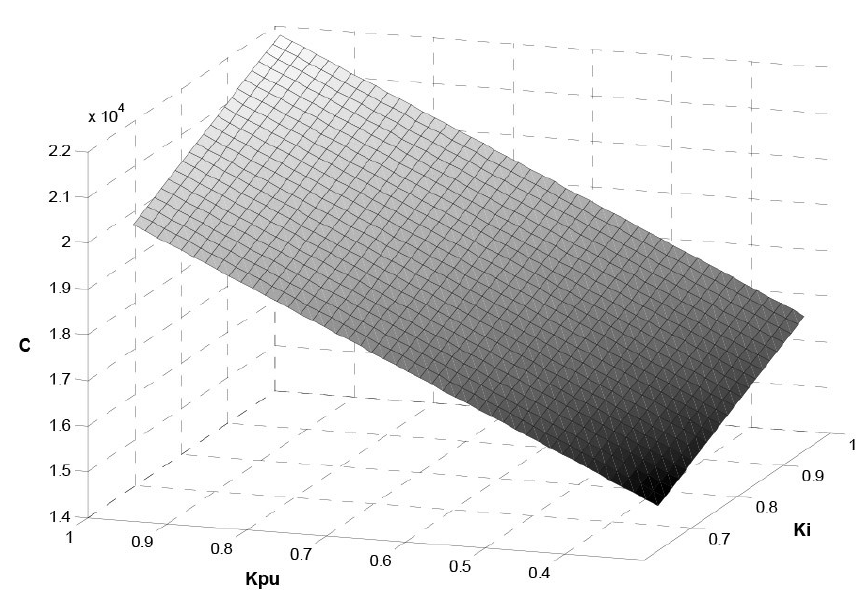
Figure 7. Location of safety stock-Case 2